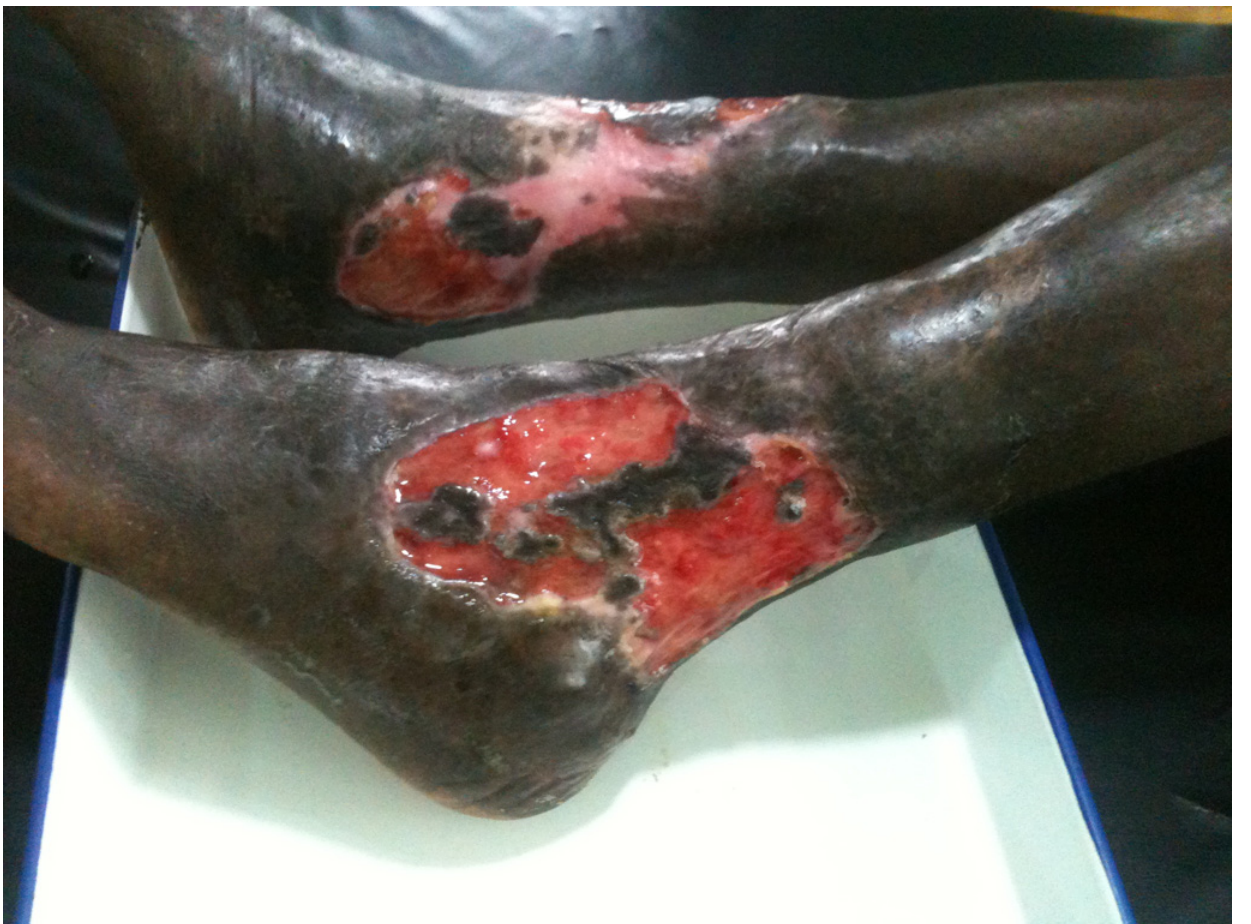
Fig 1. Image illustrating the severity of lesions in Buruli ulcer-HIV coinfected individuals; extensive bilateral ankle ulcers.